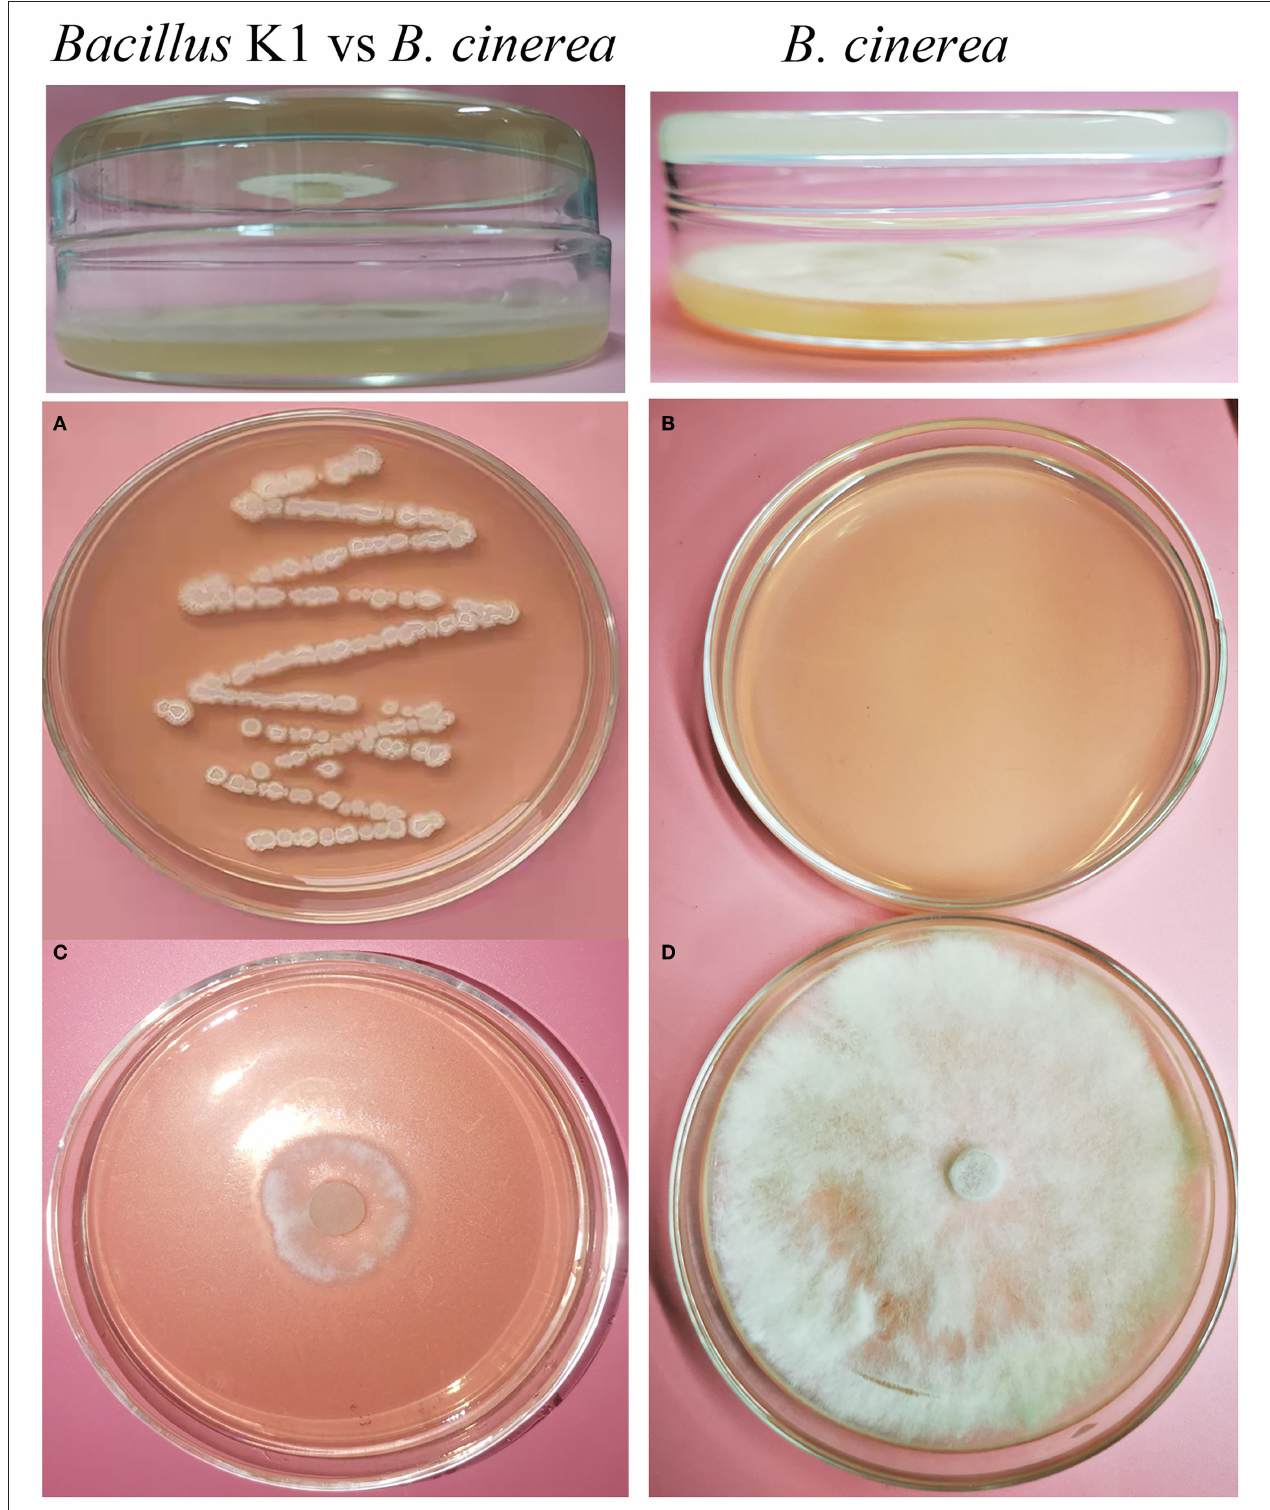
FIGURE 2 | Inhibition of Botrytis cinerea by endophytic Bacillus strain K1 in double plate assay. (A) Endophytic Bacillus strain K1. (B) Blank plate as control (without endophyte). (C) Inhibition of B. cinerea by Bacillus strain K1. The petri plate with the bacterial strain K1 was inverted over the plate inoculated with the B. cinerea and incubated. (D) B. cinerea as control (without endophyte). In control, the blank petri plate was inverted over the B. cinerea plate.